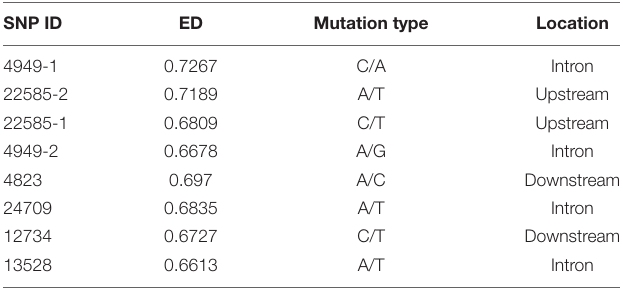
TABLE 1A | SNP statistics from HSPs which differentiated in gene structure and expression.